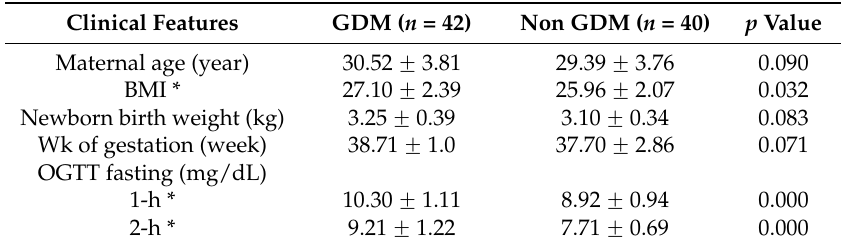
Table 1. Clinical characteristics of the studied